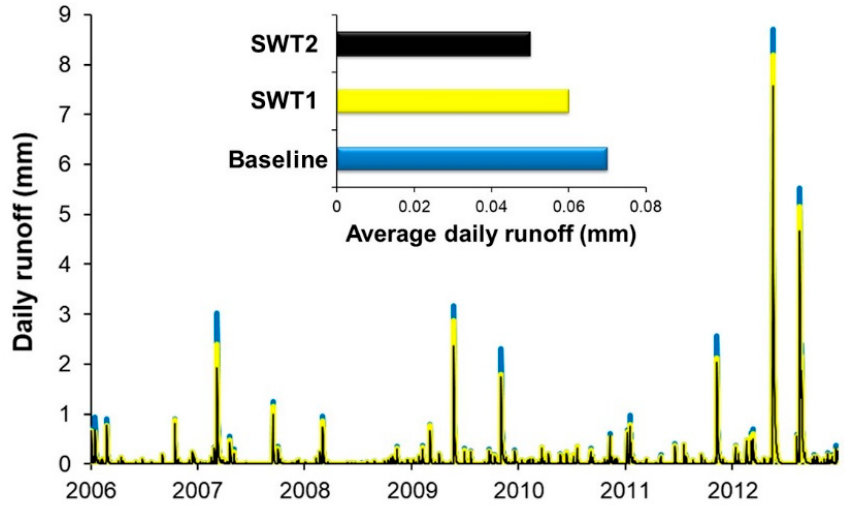
Figure 15. The daily surface runoff for the Santa Catalina stream basin for the 2006–2012 period under three different scenarios: baseline scenario (blue), SWT1 “land use change” scenario (yellow), and SWT2 “land use change combined with contour farming” scenario (black).